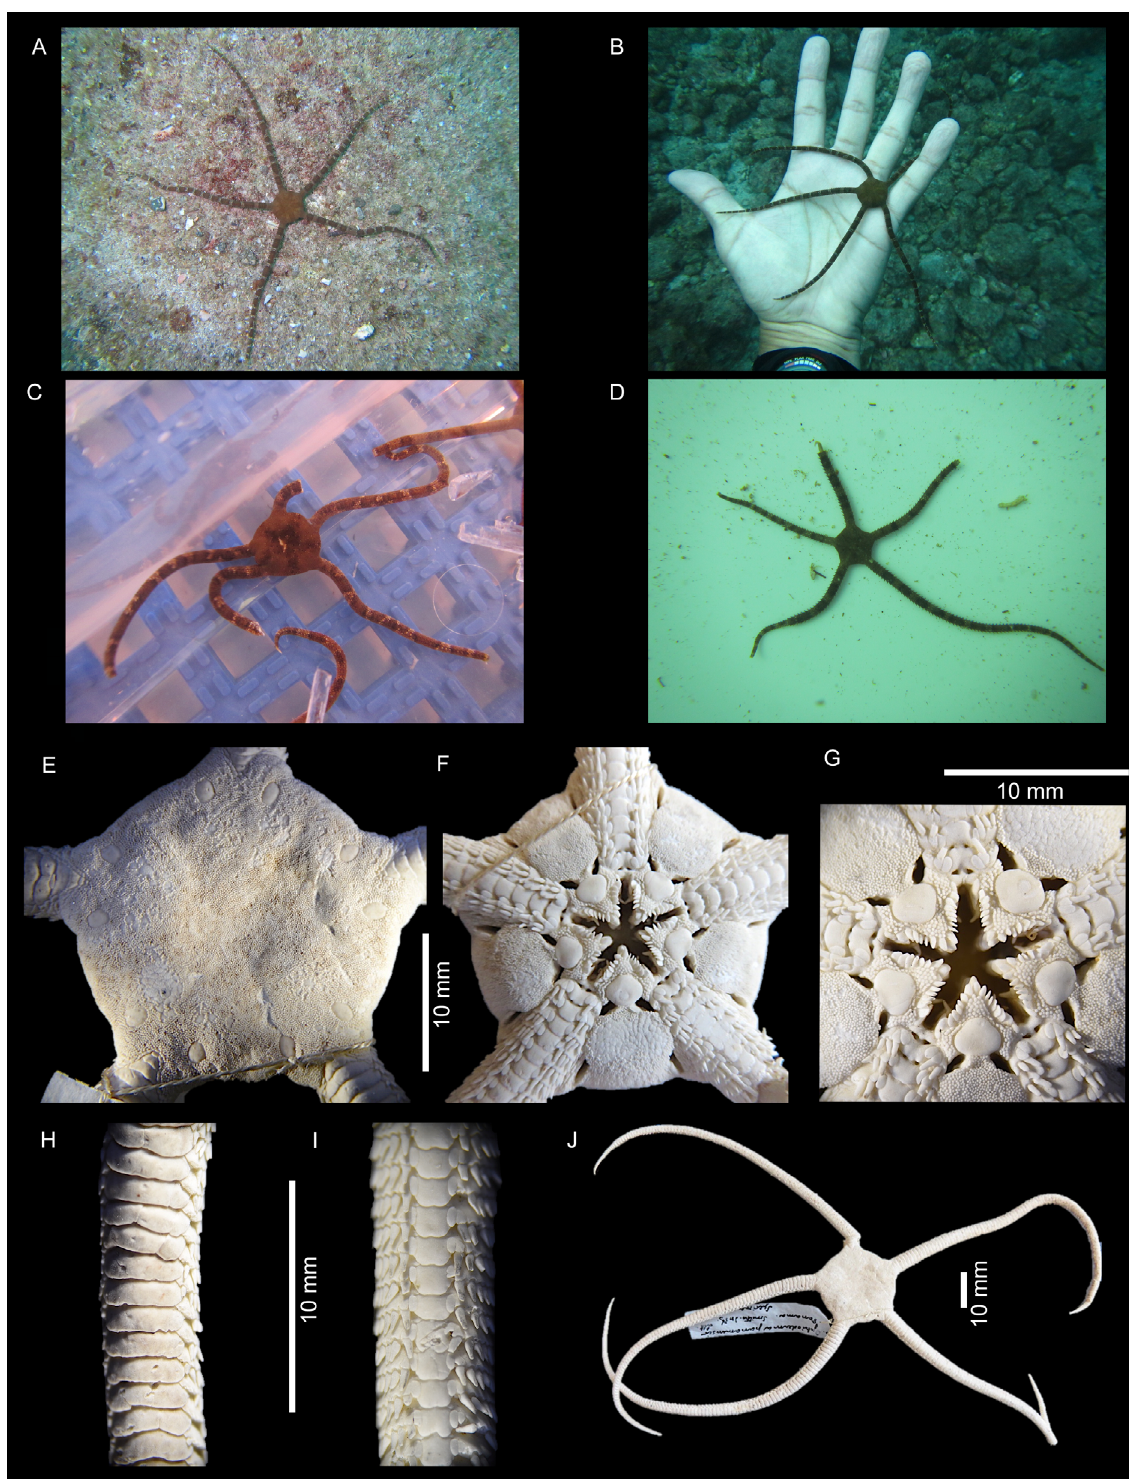
Fig. 5. A–D . Ophioderma hendleri sp. nov. A–B . In vivo coloration in natural habitat. C–D . In vivo coloration of collected specimens. – E–J . Ophioderma panamense Lütken, 1859, holotype (NHMD- 107679, DD = 21.9 mm). E . Dorsal disc. F . Ventral disc. G . Mouth. H . Dorsal arm. I . Ventral arm. J . Dorsal